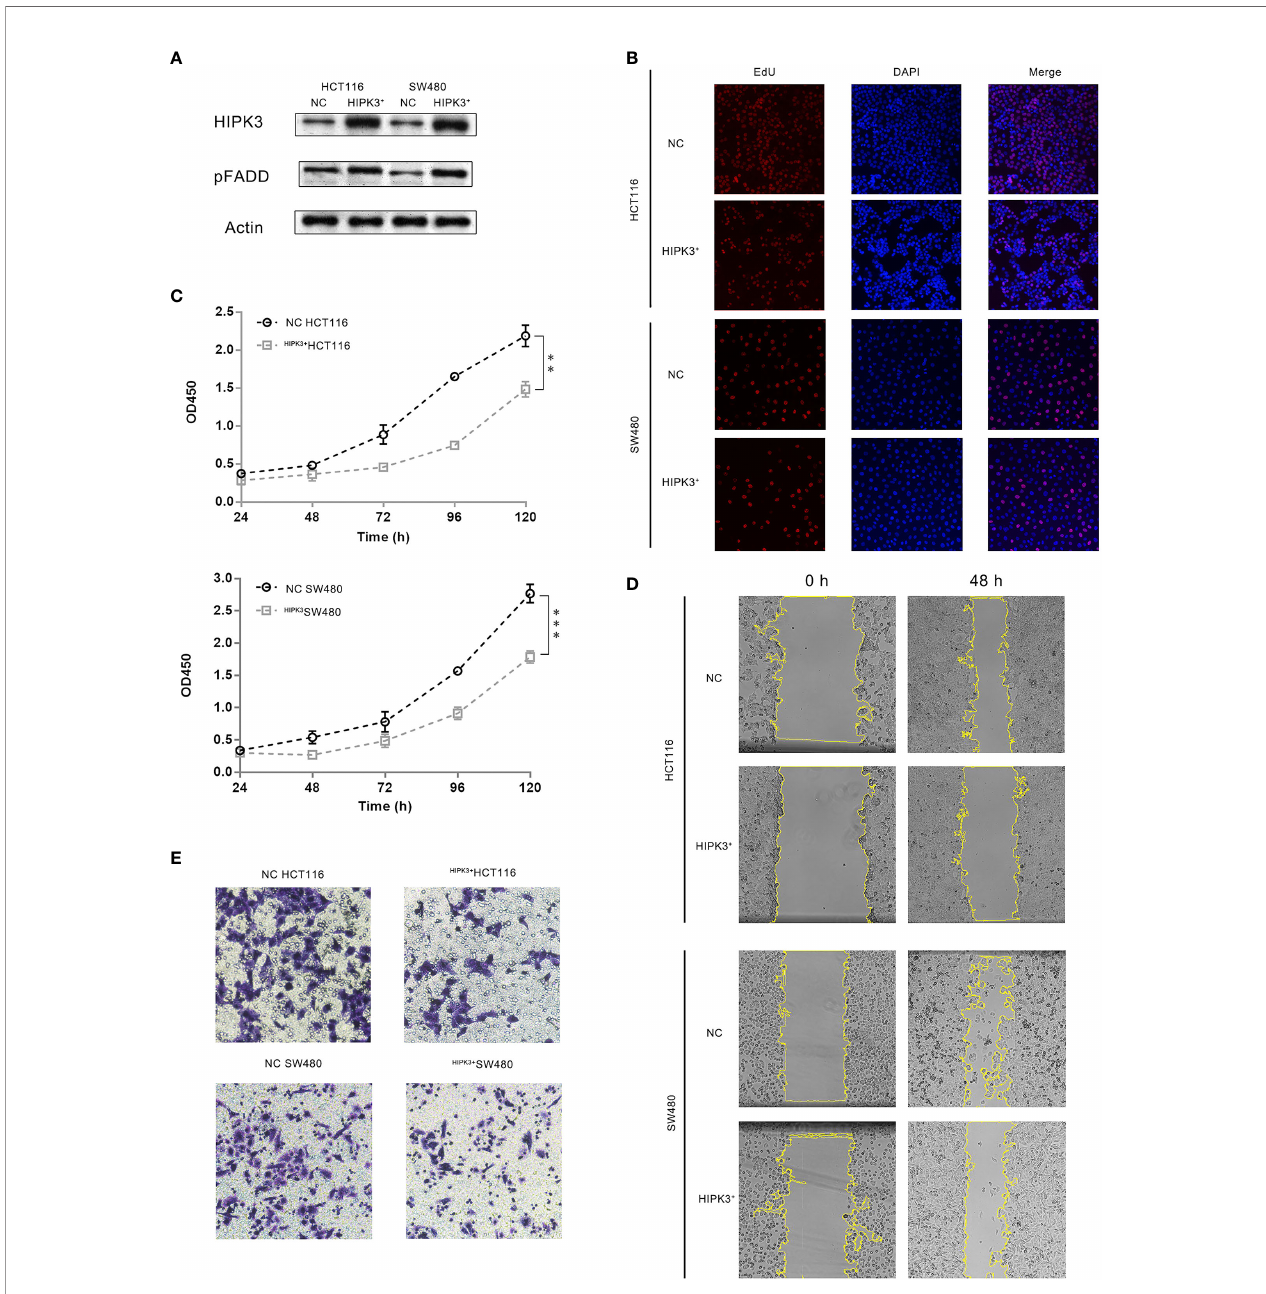
FIGURE 3 | CRC cells stably over-expressing HIPK3 exhibited decreased oncogenic potential. (A) Immunoblots of HIPK3, pFADD in HCT116 and SW480 cells stably over-expressing HIPK3. (B) EdU incorporation assay of HCT116 and SW480 cells stably over-expressing HIPK3. (C) Growth curves of HCT116 and SW480 cells stably over-expressing HIPK3. (D) Wound healing assay of HCT116 and SW480 cells stably over-expressing HIPK3. (E) Transwell assay of HCT116 and SW480 cells stably over-expressing HIPK3. **, *** correspond to a p-value less than 0.01 and 0.001,